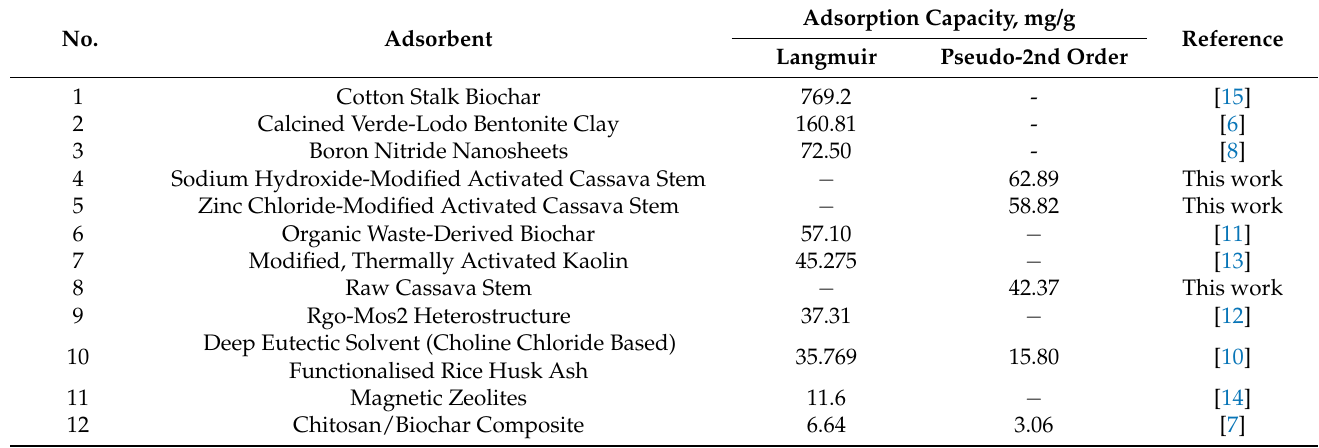
Table 10. Comparison of the maximum adsorption capacity for different ofloxacin